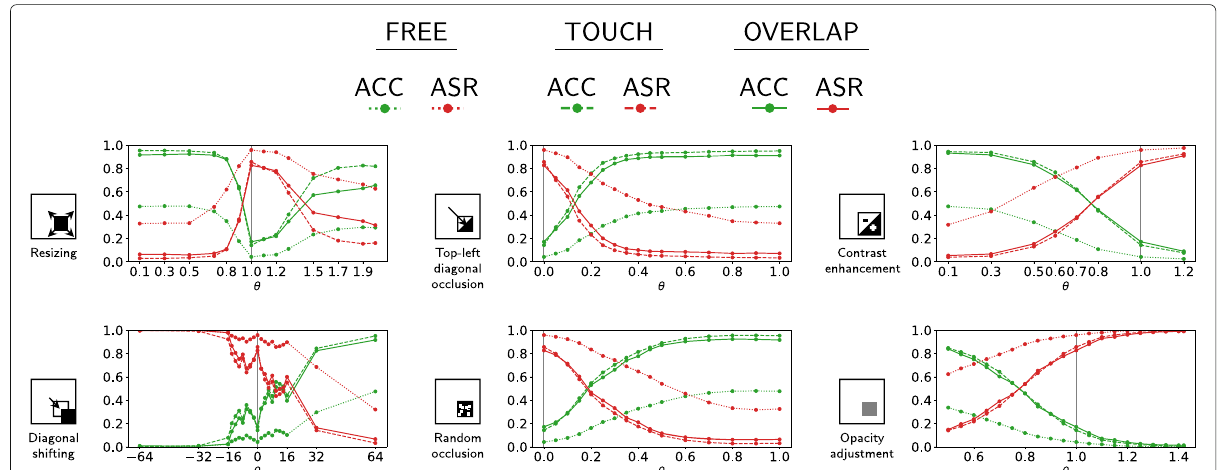
Fig. 7 Overlap with image content: ACC and ASR values for selected transformations aggregated by